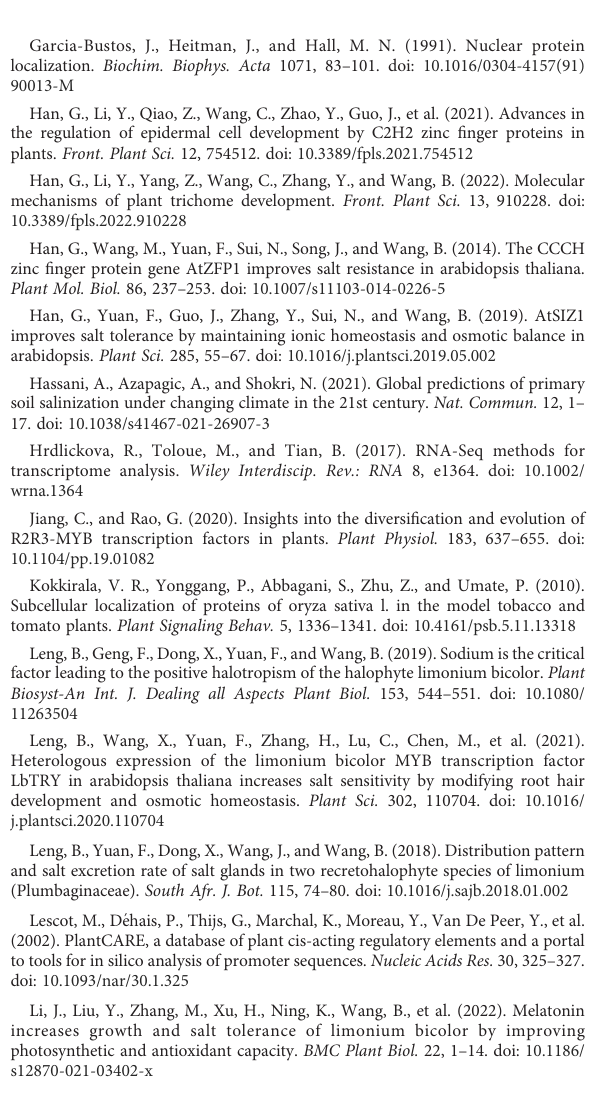
SUPPLEMENTARY FIGURE 3 Area comparison of other epidermal cells in TRV ::LbMYB48 and TRV :: 0 lines. Three replicates should be set up to calculate the standard deviation (SD) and ensure accuracy.